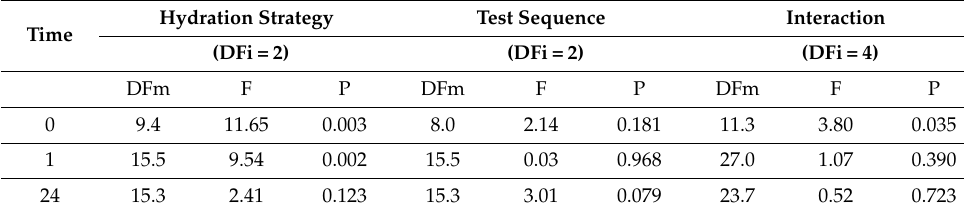
Table 4. Results of analysis of variance for the change in plasma volume ∆ PV calculated from HB and HCT results measured before and 0, 1, and 24 h after the exercise test: significance of (P) and F-statistic along with the number of degrees of freedom (DFi—in the numerator; DFm—in the denominator) for the fixed effects (hydration strategy, test sequence, and their